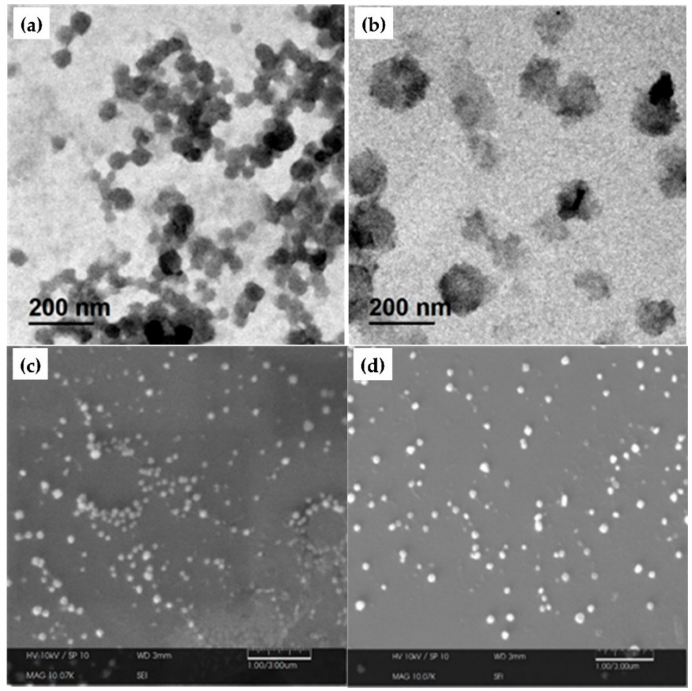
Figure 3. TEM images of ( a ) NE and ( b ) NE( κ -CAR/CS) 2 . SEM images of ( c ) NE and ( d ) NE( κ -CAR/CS) 2